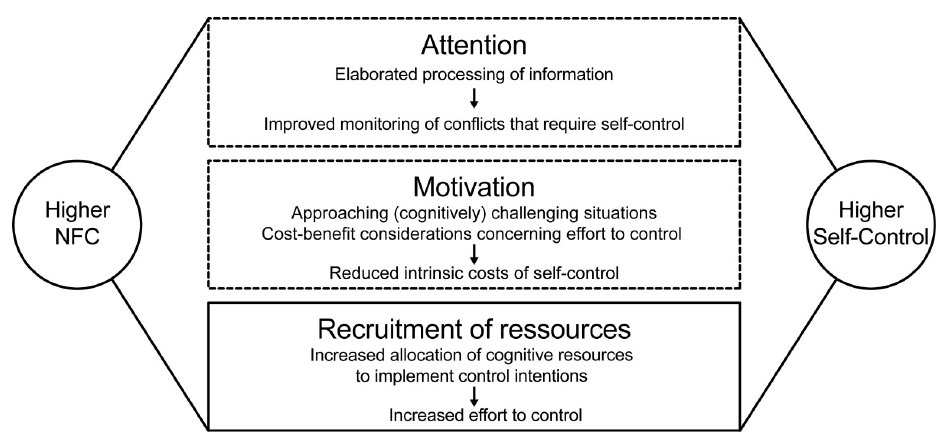
Fig 1. Processes linking Need for Cognition to Self-Control. NFC = Need for Cognition. Illustration of potential explanatory mechanisms that can be derived from literature. The solid-line box represents the role of Action Orientation related to resource allocation for the prediction of Self-Control by Need for Cognition while the dashed- line boxes represent explanatory mechanisms this study did not focus on.